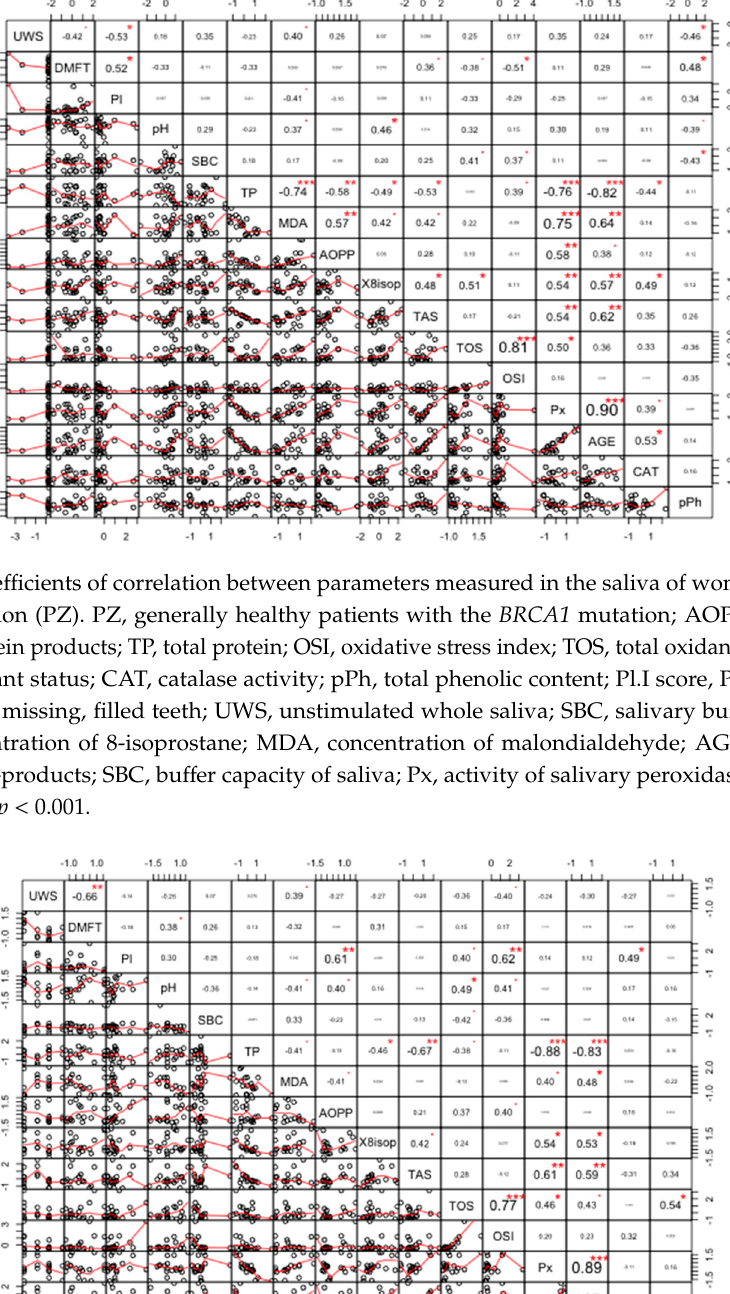
Figure 15. Coe ffi cients of correlation between parameters analyzed in the saliva of women with both breast cancer and the BRCA1 mutation (PC). PC, patients with both breast cancer and the BRCA1 mutation. AOPP, advanced oxidation protein products; TP, total protein; OSI, oxidative stress index; TOS, total oxidant status; TAS, total antioxidant status; CAT, catalase activity; pPh, total phenolic content; Pl.I score, Plaque Index; DMFT, decay, missing, filled teeth; UWS, unstimulated whole saliva; SBC, salivary bu ff er capacity; 8-isop, concentration of 8-isoprostane; MDA, concentration of malondialdehyde; AGE, advanced glycation end-products; SBC, bu ff er capacity of saliva; Px, activity of salivary peroxidase. * p < 0.05; ** p < 0.01, *** p <